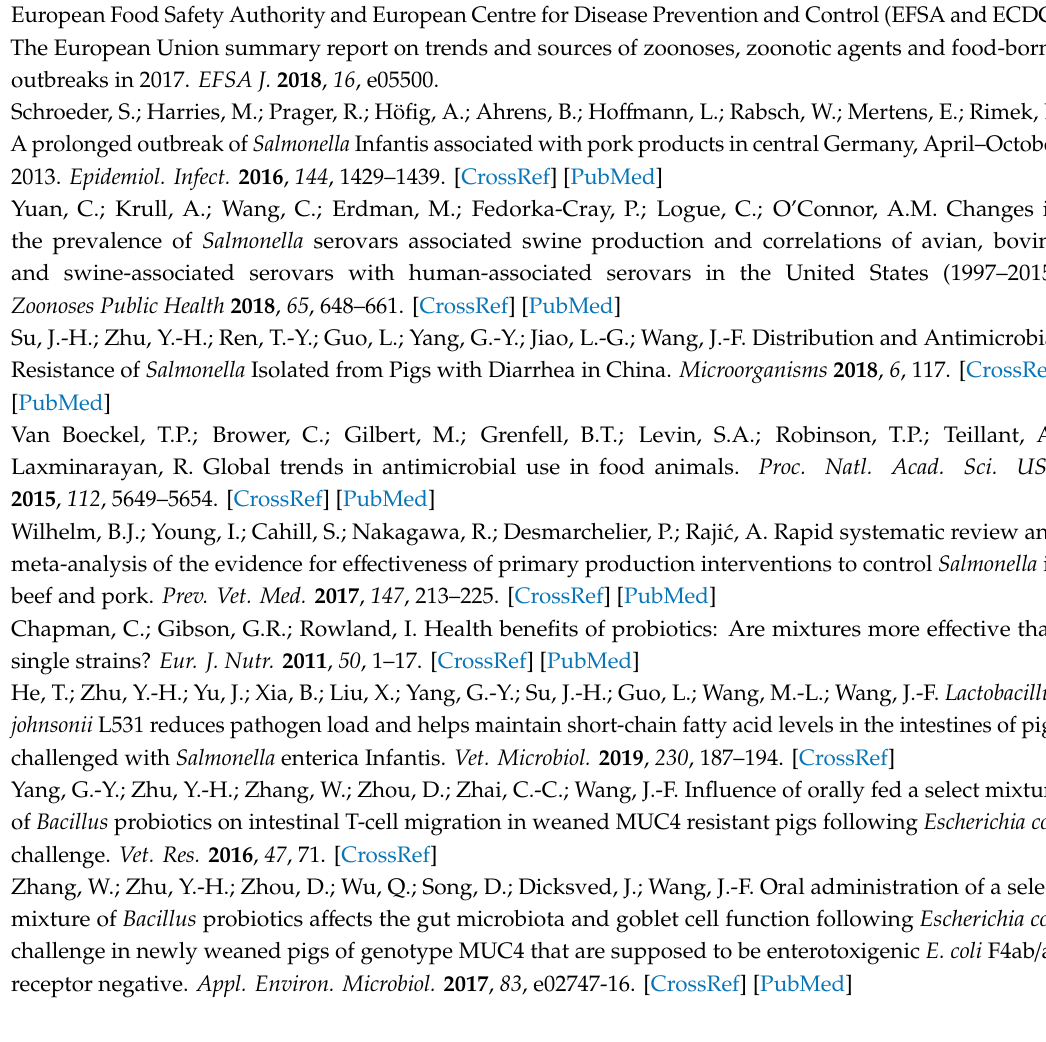
Table S1: E ff ects of oral administration of LBB-mix on the incidence of diarrhea in newly weaned pigs before and after S . Infantis